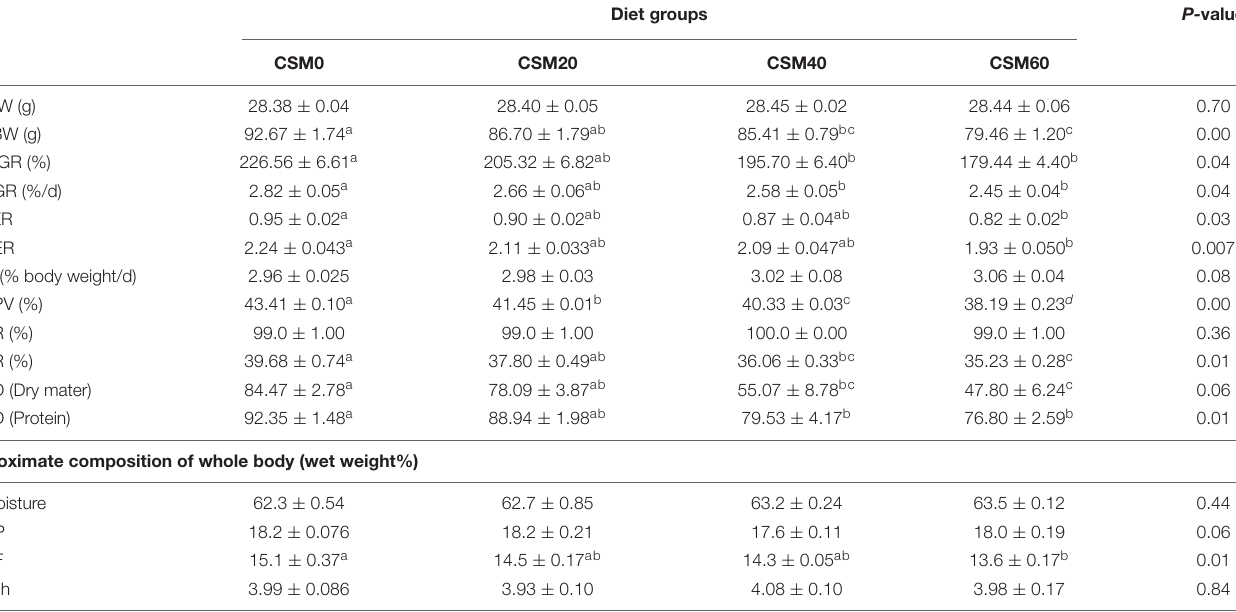
TABLE 4 | Growth performance, feed utilization, apparent digestibility, and proximate composition of whole body of golden pompano fed the different experimental diets. Diet groups P- value